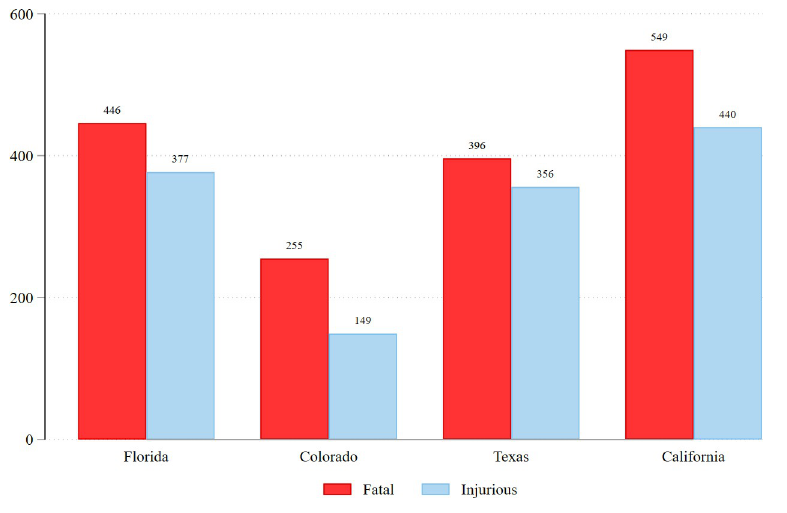
Fig 1. Fatal and injurious police shootings in each